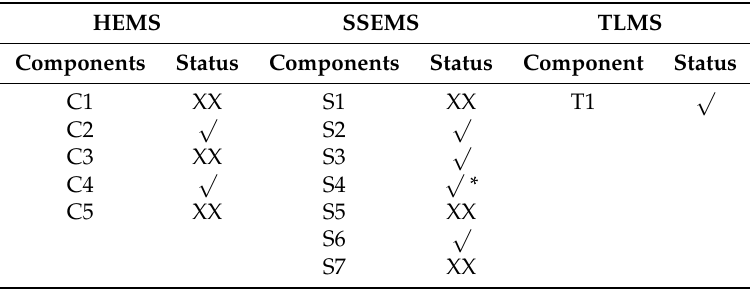
Table 1. Management systems and their components considered. HEMS SSEMS TLMS